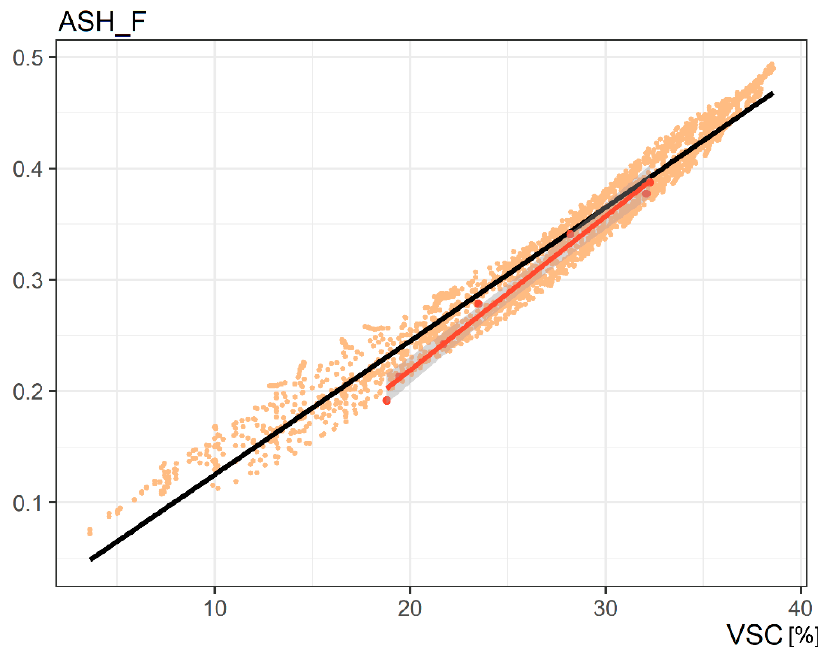
Figure 23. Linear regression function of façade-based metrics VSC and ASH_F based on neighbour- hood iterations (black line) and case studies (red line), including the 95% CI for the case studies regression line indicated by the grey area.